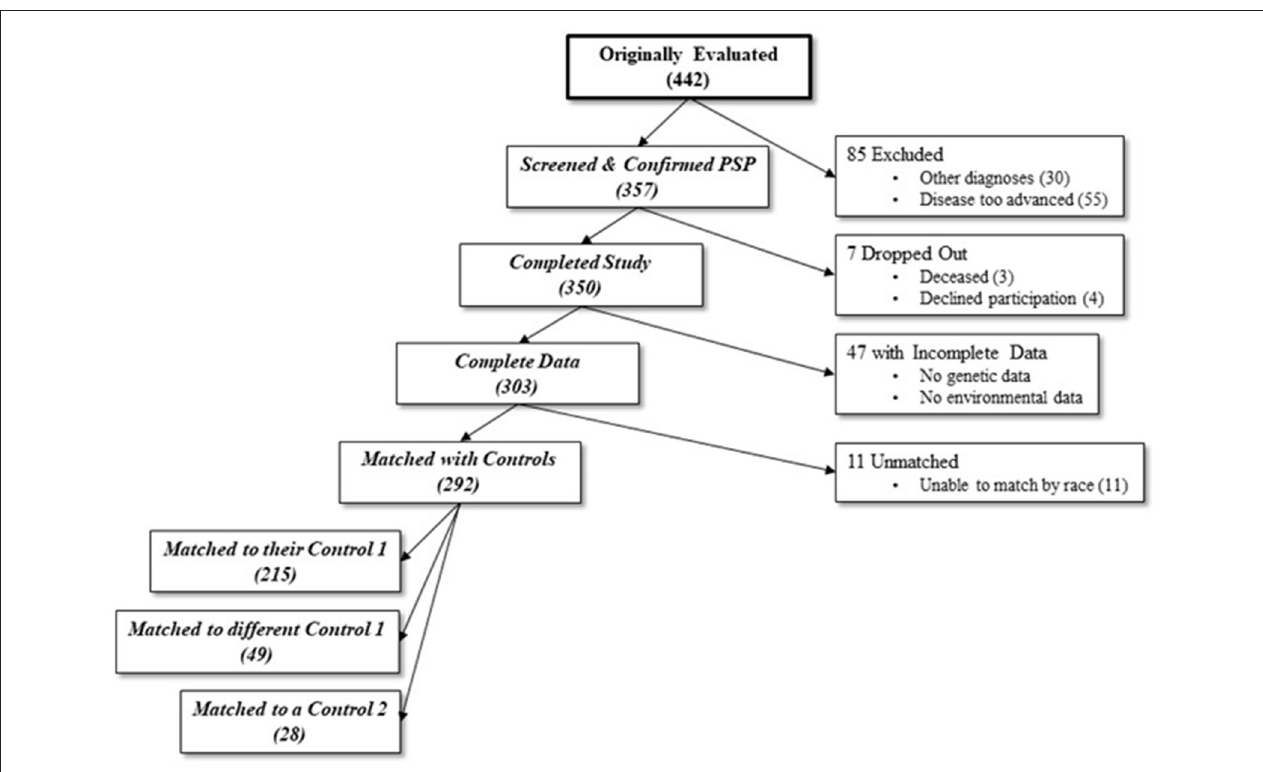
FIGURE 1 | Number of participants at each stage of the study. From an initial sample of 442, 139 were excluded due to either incompatible diagnoses, too advanced disease, dropping out, or incomplete data. An additional 11 were excluded due to inability to match for race with a control. 292 final cases were matched with either their original control 1 (non-blood relative), a different case’s control 1, or a different case’s control 2 (spouse or